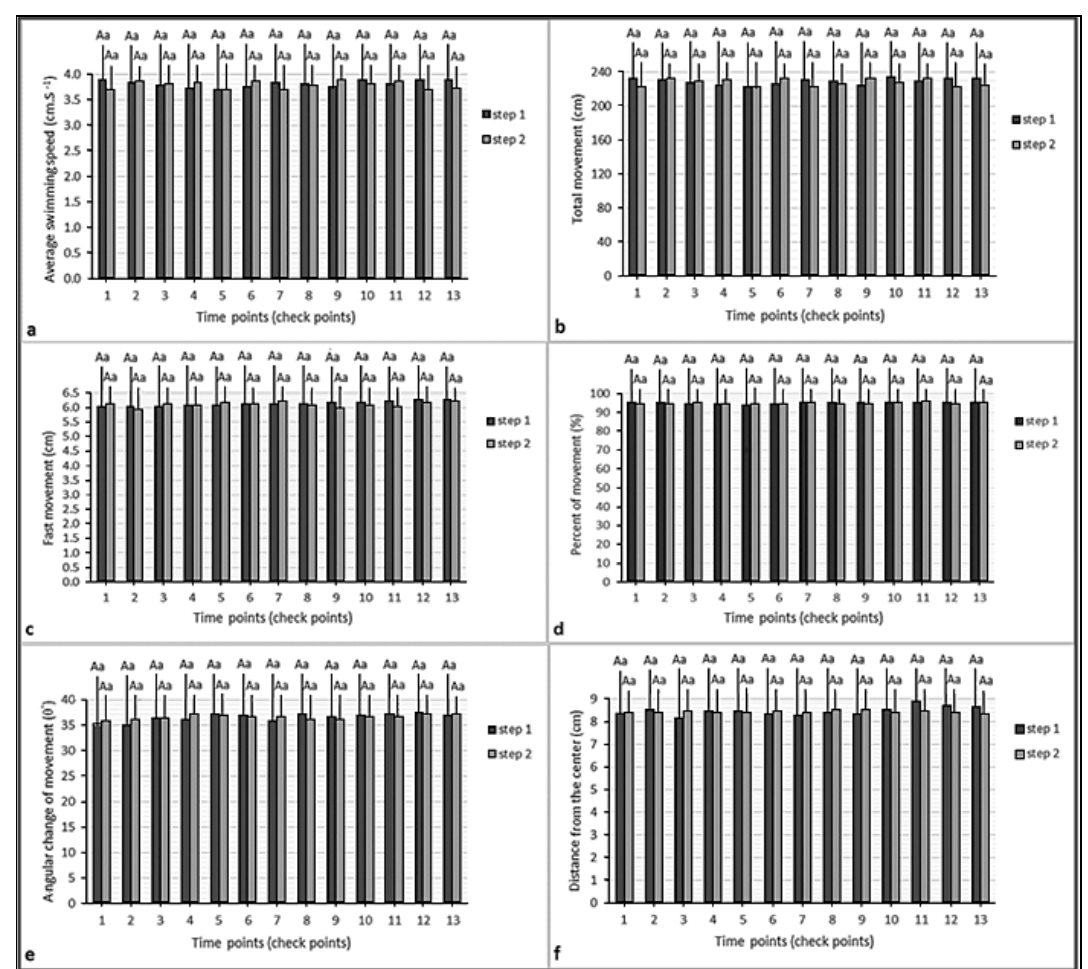
Figure 3. Parameters of swimming pattern of the fish in the control group: ( a ) average speed; ( b ) total movement; ( c ) fast movement; ( d ) percent of movement; ( e ) average angular change of movement; ( f ) distance from the center. Similar lowercase letters (a) indicate nonsignificant differences between values of the same color columns ( p > 0.05). Similar uppercase letters (A) indicate nonsignificant differences between values of paired columns ( p > 0.05).